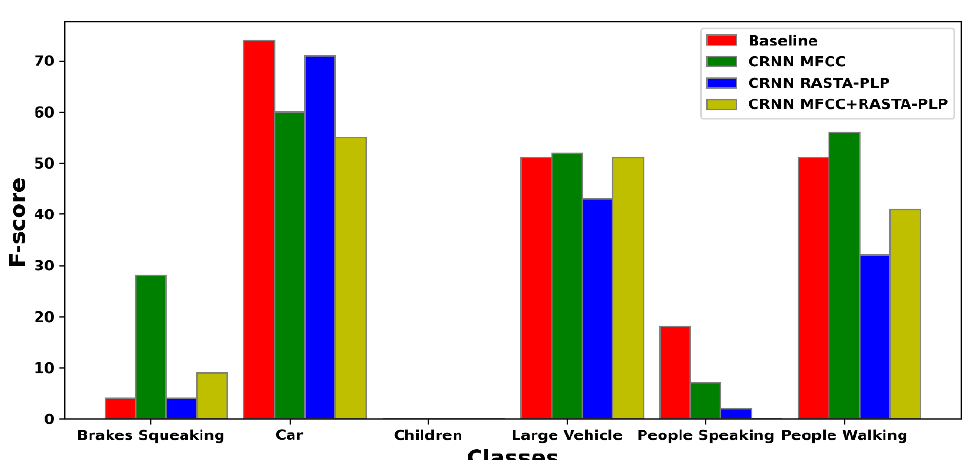
Figure 8. F1-score comparison using CRNN classifier.